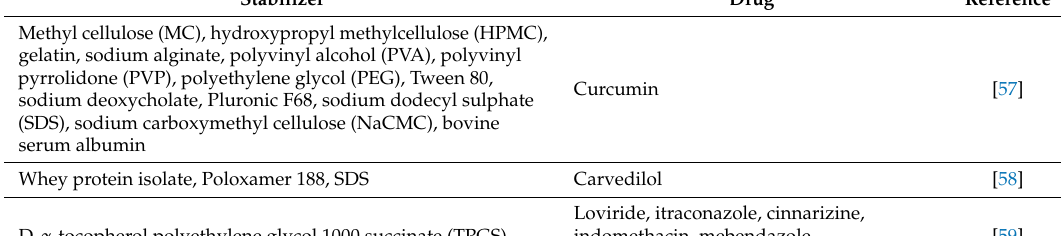
Table 1. Examples of different stabilizers used in screening studies for production of drug nanocrystals. Stabilizer Drug